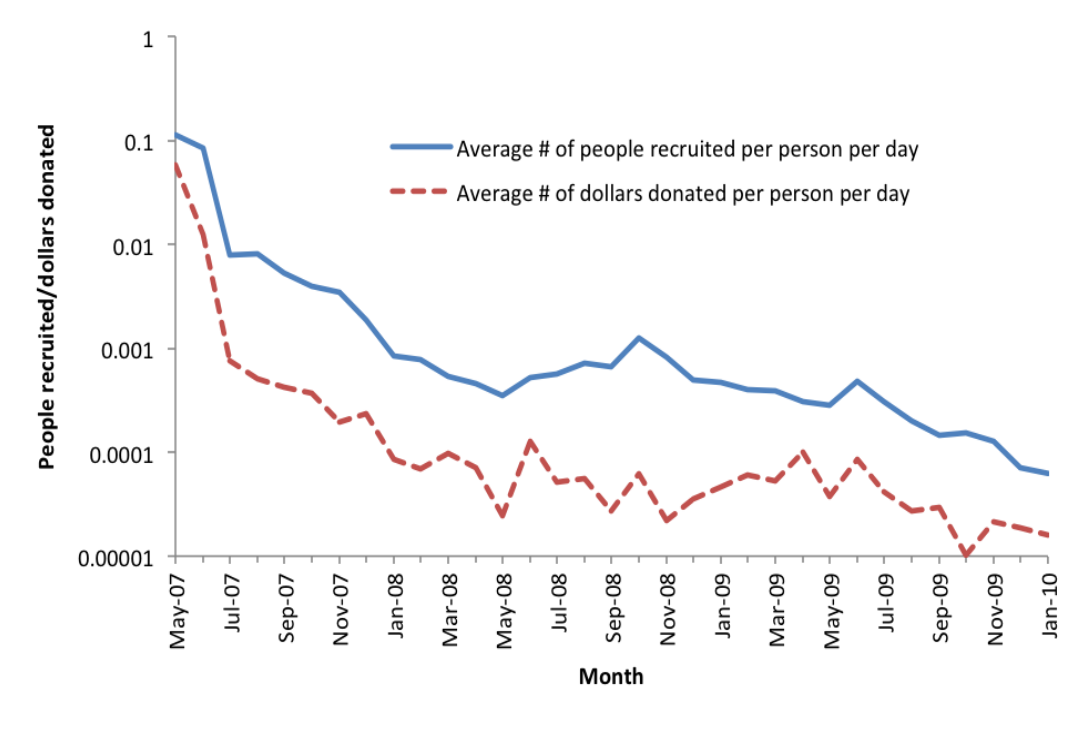
Figure 4: Decline of individual participation shown via a final portrait of the evolution of the Save Darfur Cause, here represented as daily rates of per-person activity (averaged over each month to enhance visibility) as opposed to daily rates of overall increases (as in Fig. 2). The y axis is in logarithmic